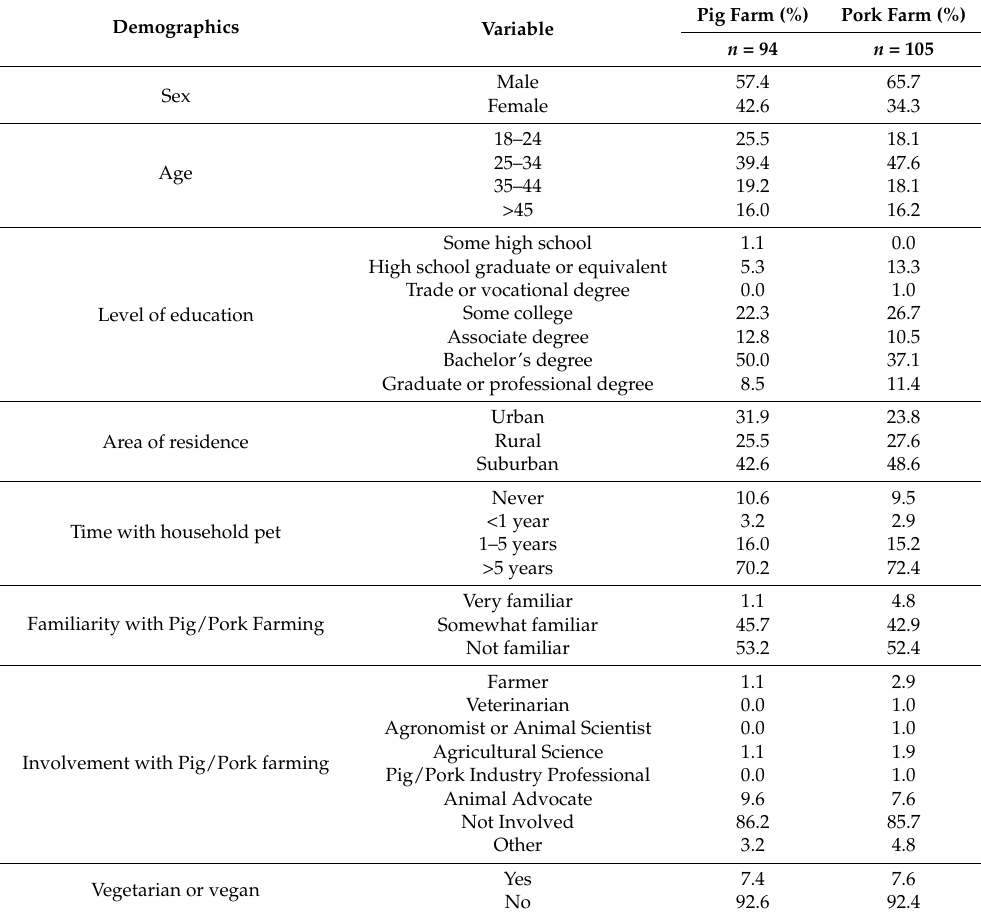
Table 2. Participant demographics of the cohorts that participated in an online survey where they were asked to respond to the question, “What do you consider to be an ideal pig/pork farm and why are these characteristics important to